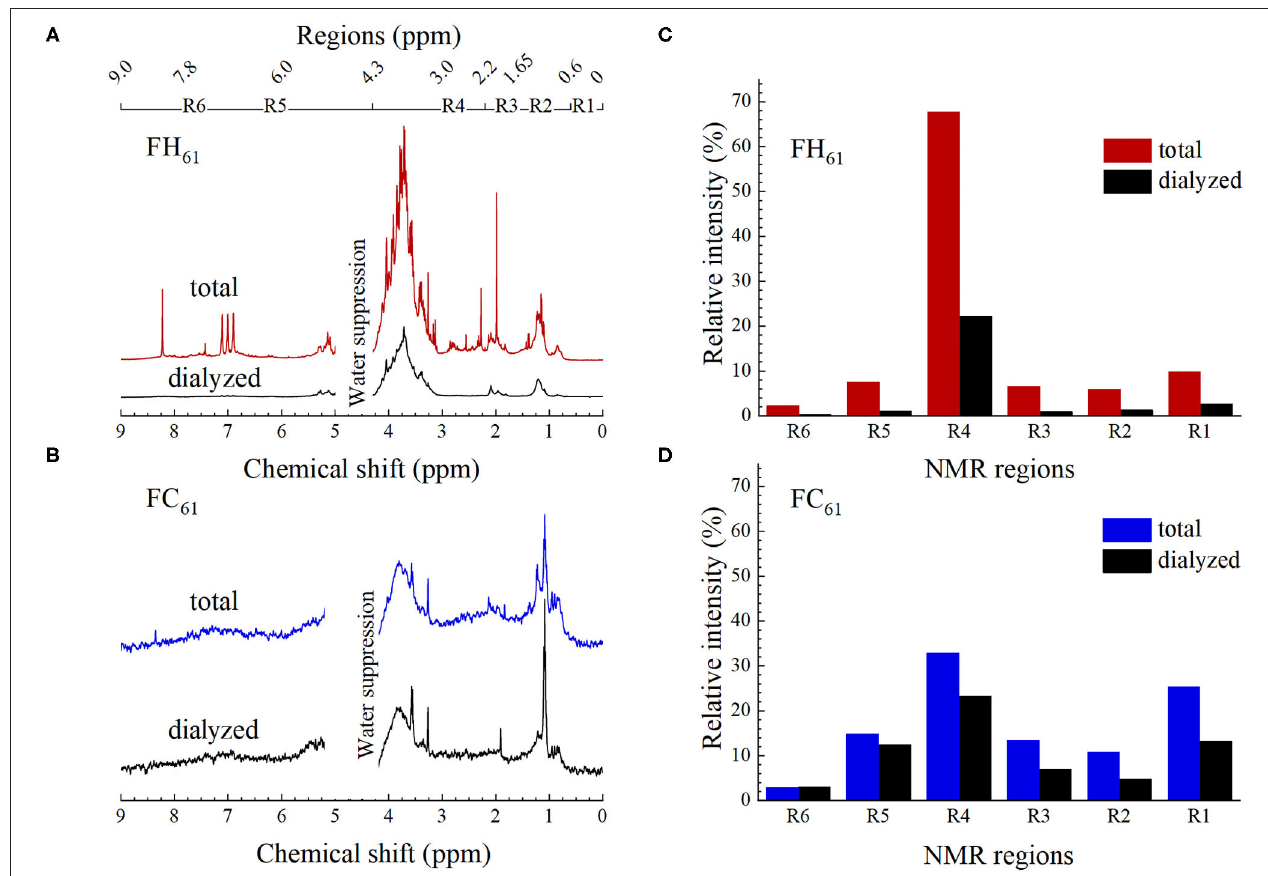
FIGURE 3 | High-resolution 1 H-NMR spectra of (A) total and dialyzed FH 61 (B) total and dialyzed FC 61 ; corresponding peak area integrals normalized to the area of the total DOM spectra of (C) hot and (D) cold DOM. Spectra and their corresponding normalized integrals of all other samples are shown in Supplementary Figures S3, S4 , including